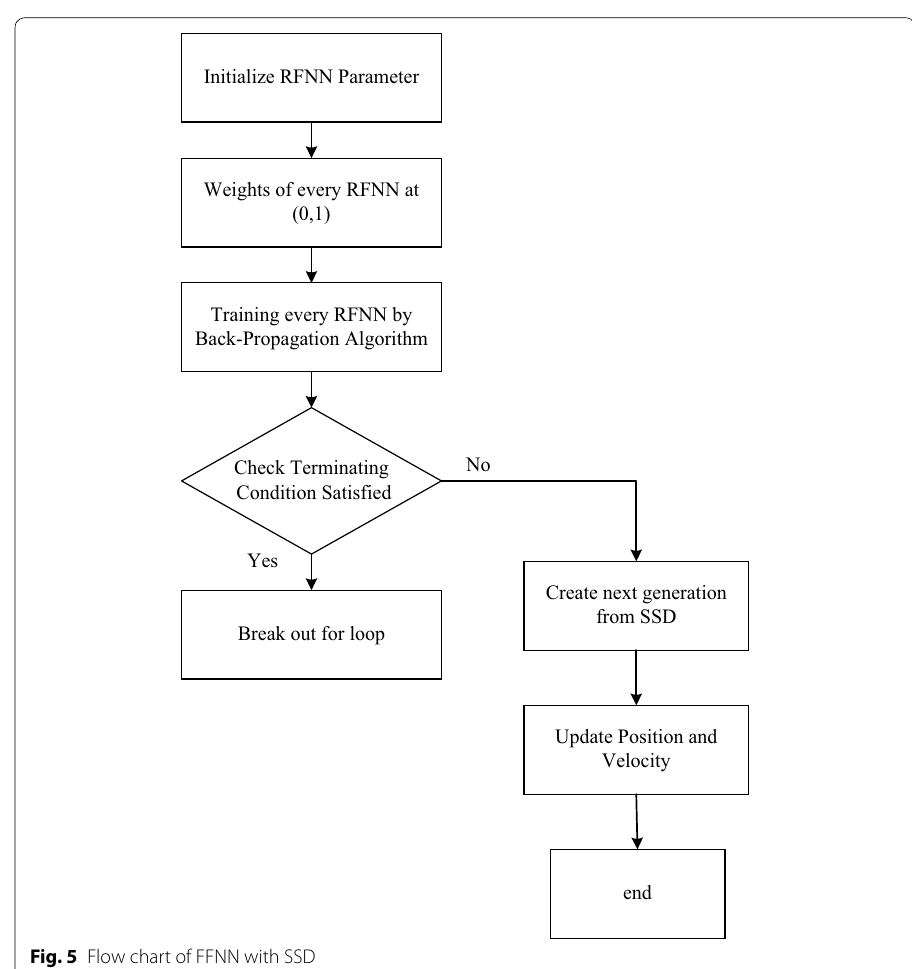
Fig. 5 Flow chart of FFNN with